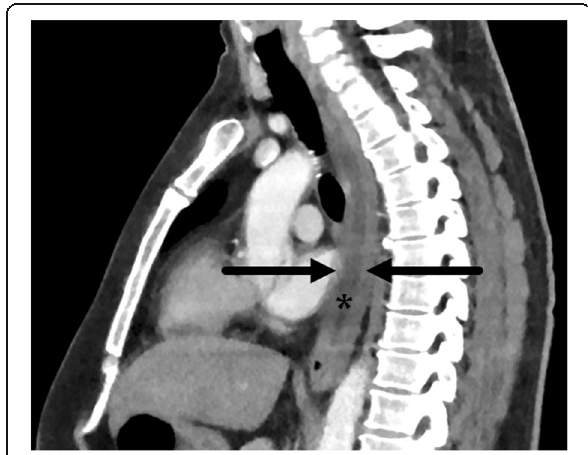
Fig. 10 Acute esophagitis. Fifty-year-old male with diffuse chest pain and mild fever. Sagittal CT image show diffuse circumferential wall thickening with mild enhancement involving almost entire esophagus (arrows). Intraluminal fluid (asterisk) is